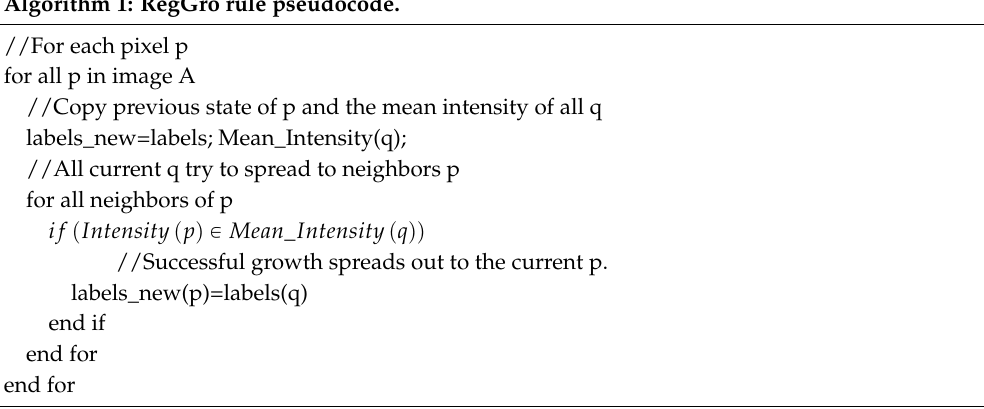
Algorithm 1: RegGro rule